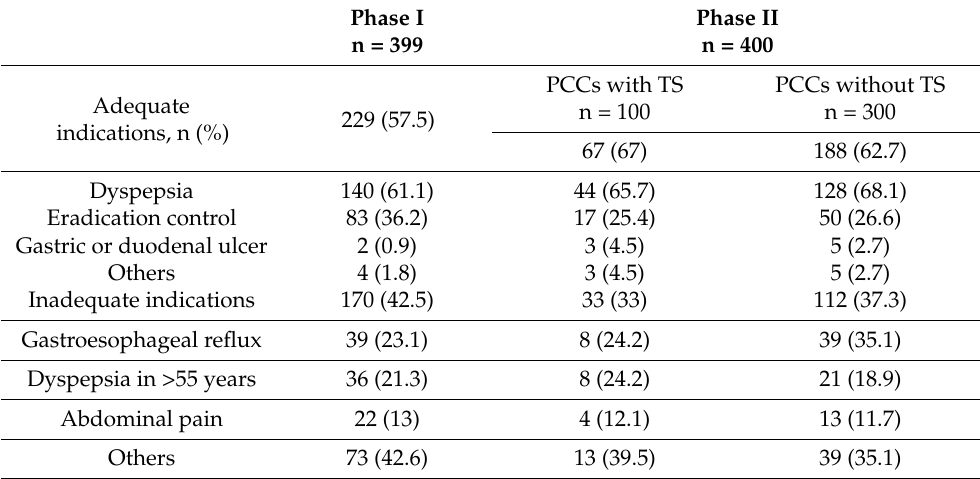
Table 1. Most frequent indications for urea breath test in Phase I and II.